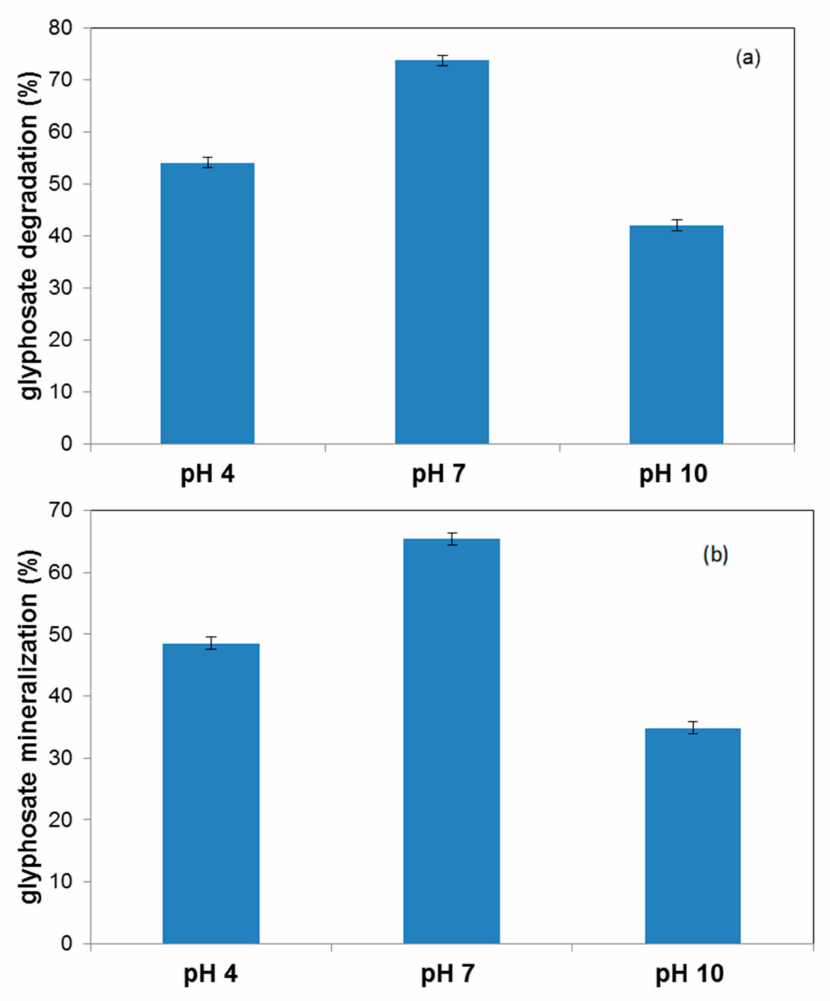
Figure 9. Photocatalytic glyphosate degradation ( a ) and mineralization ( b ) at different pH solutions during the irradiation time; glyphosate concentration = 10 mg/L; catalyst dosage = 1.5